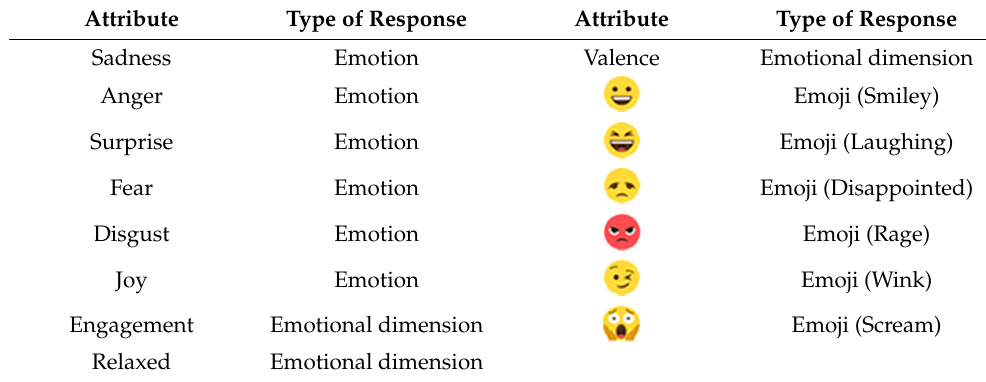
Table 3. Attributes obtained from the participants’ video analysis for emotional responses.